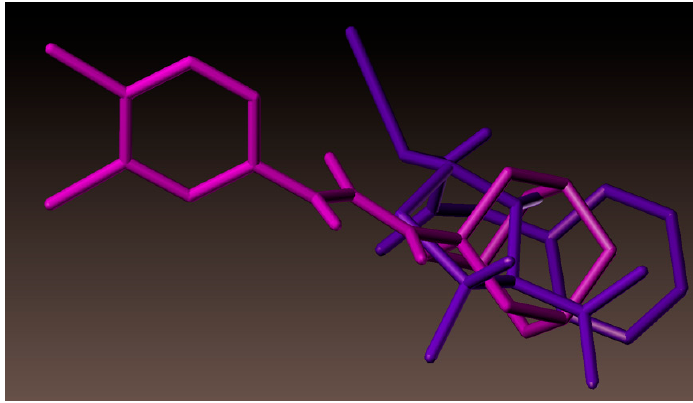
Figure 9. Superimposition of compound 3l (magenta color) with benzyl penicillin (purple color).